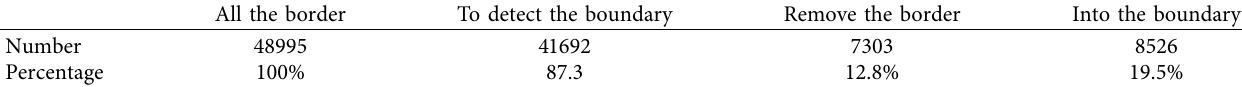
Table 2: Boundary detection results based on a posteriori probability vector of phonemic attributes. All the